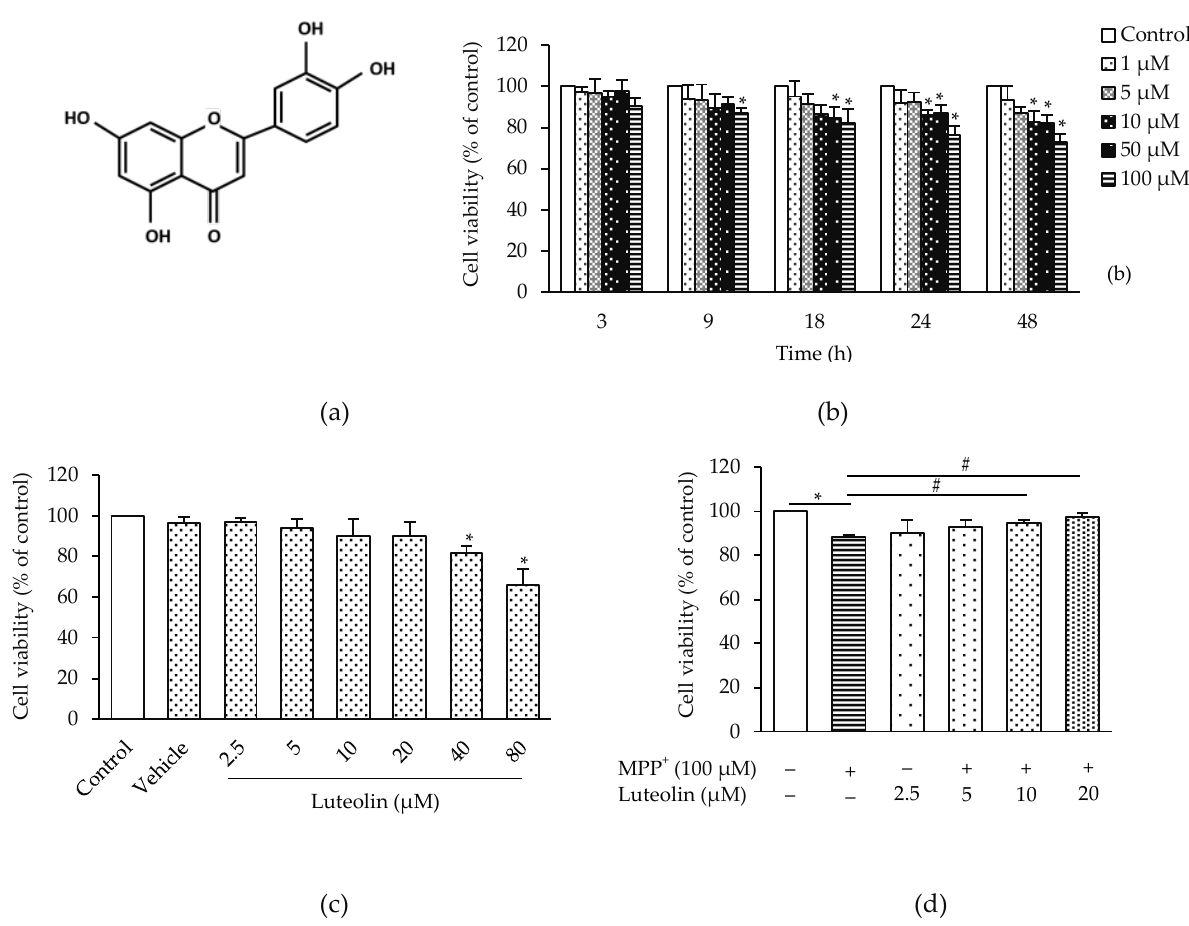
Figure 1. Luteolin prevented 1-methyl-4-phenylpyridinium iodide (MPP+)-induced neurotoxicity in SH-SH5Y cells. ( a ) Chemical structure of luteolin. ( b ) The cells were treated with various concentrations of MPP + (0–100 µ M) for 3, 9, 18 and 24 h. ( c ) The cells were treated with various concentrations of luteolin (0–80 µ M) for 24 h. ( d ) The cells were pre-treated with luteolin (2.5–20 µ M) for 1 h followed by 100 µ M MPP + for 24 h. Cell viability was measured by 0.5 mg/mL of 3-(4,5-dimethylthiazol-2-yl)-2,5-diphenyl tetrazolium bromide (MTT) assay. Results are shown as the mean ± SD for triplicate independent experiments. Differences are statistically significant at * p < 0.05 versus the control group, and # p < 0.05 versus the MPP + group.